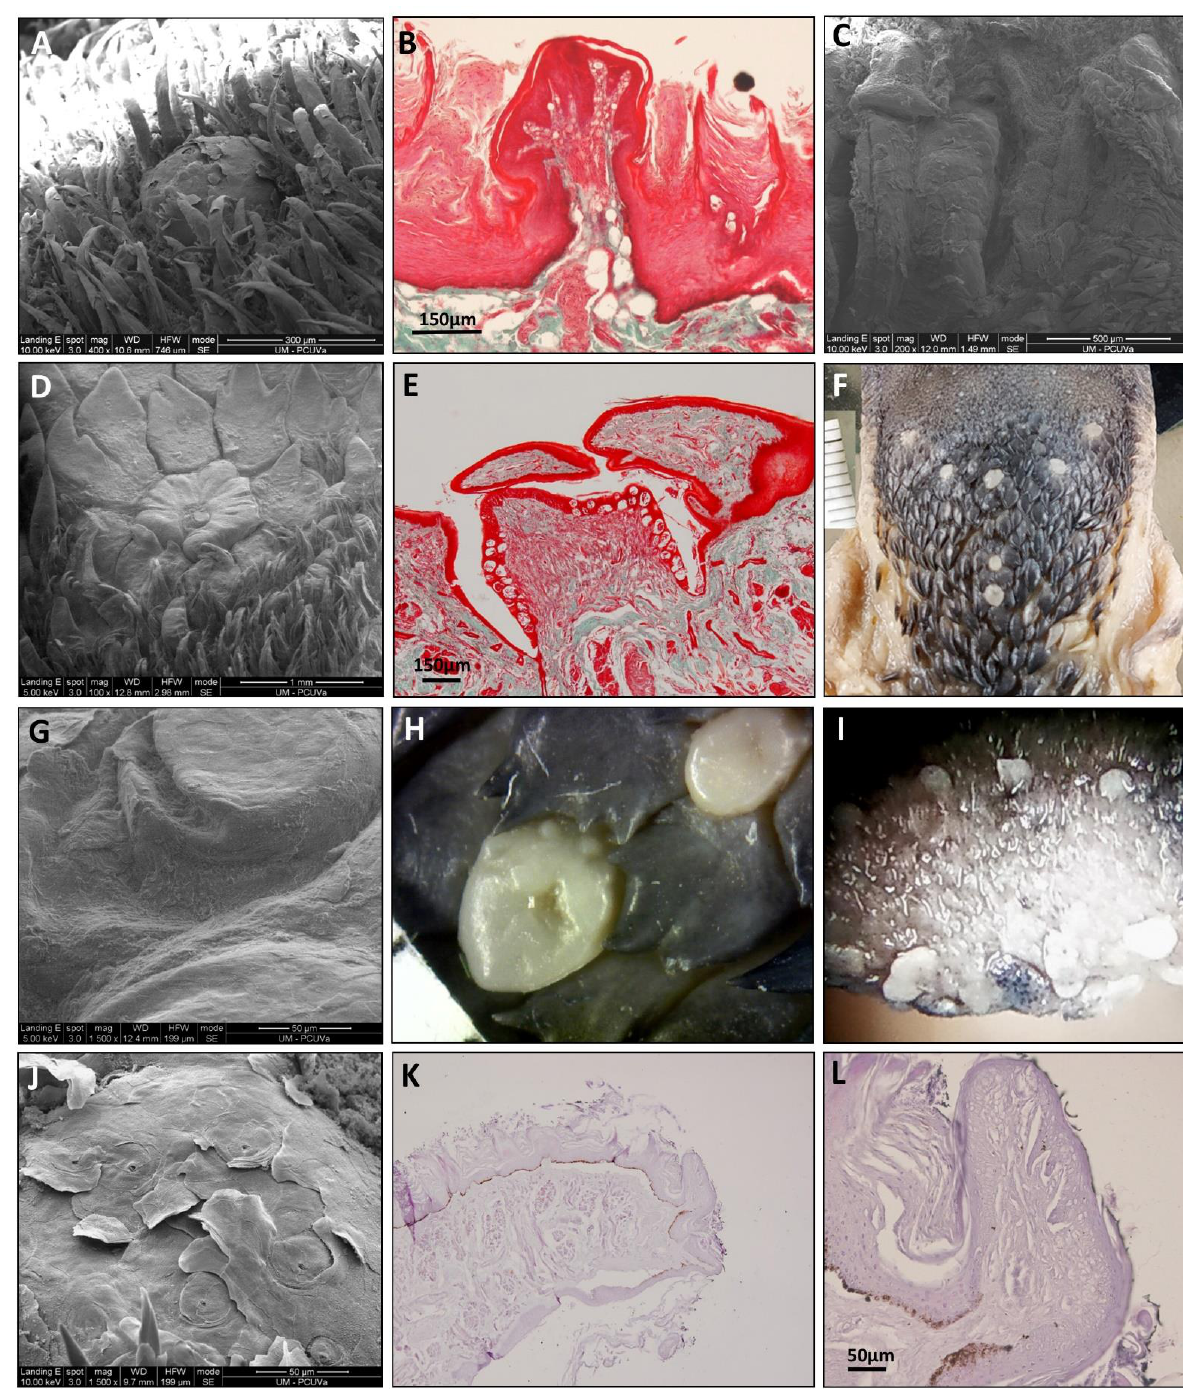
Figure 7. All images correspond to Varecia variegata papillae. SEM images can be observed of fungiform together with filiform ( A ), foliate ( C ), circumvallate ( D , F ), surrounded by flattened conical with several tips and some filiform in the inferior part of the image, a circumvallate central part ( G , magnified from image D circumvallate papilla) and a superior view of hammerhead or maze-shaped papillae present on the tip of the tongue ( J ). Also presented are Masson trichrome- stained images of filiform and fungiform ( B ) and a circumvallate surrounded by conical ( E ). Images ( I – L ) illustrate the hammerhead or maze-shaped papillae present on the tip of the tongue, with K and L being sagittal sections stained with hematoxylin—eosin. Image ( F ) (a superior view of the root of the tongue) shows the Y-shaped disposition of circumvallate papillae and image H displays the crest shape of the flattened conical papillae that surround circumvallate ones in Varecia variegata . A scale of one millimeter in width, can be observed on image ( H ) (inferior left angle) and in image ( F ), the minor division is also one